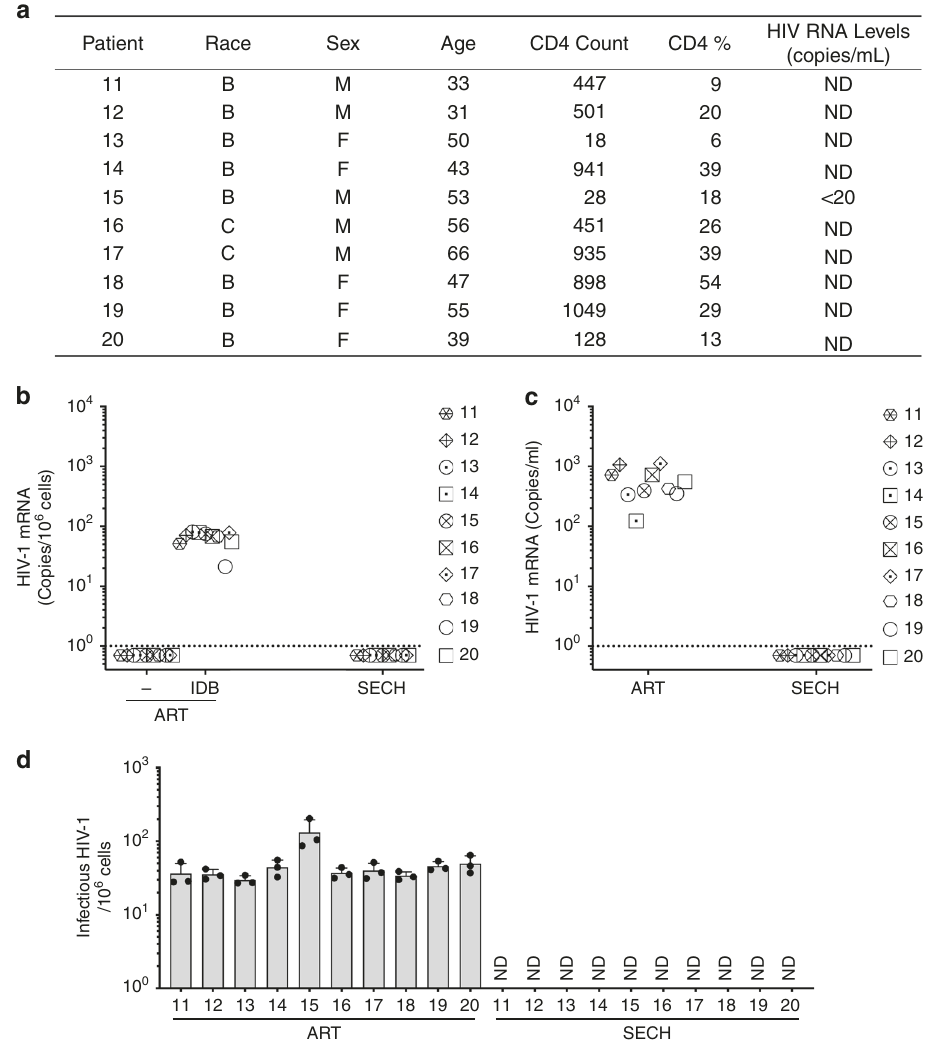
Fig. 7 Clearance of HIV-1-infected cells from ART-experienced HIV-1 patients by SECH treatments in vitro. a CD4 counts and HIV-1 load in ART- experienced HIV-1-infected patients ( n = 10). HIV viremia was successfully suppressed in all patients at the time of blood collection. Patients 18 and 19 had undergone ART treatments for 139 and 95 days, respectively. b – d PBMCs from ART-experienced HIV-1 patients ( n = 10) were treated with SECH or ART and then used for detection of HIV-1 mRNA by RT-PCR b hmVOA c and TZA analyses d as in Fig. 6. Ten biological samples were each measured in three technical replicates and presented as mean ± SD d . Source data are provided as a Source Data fi